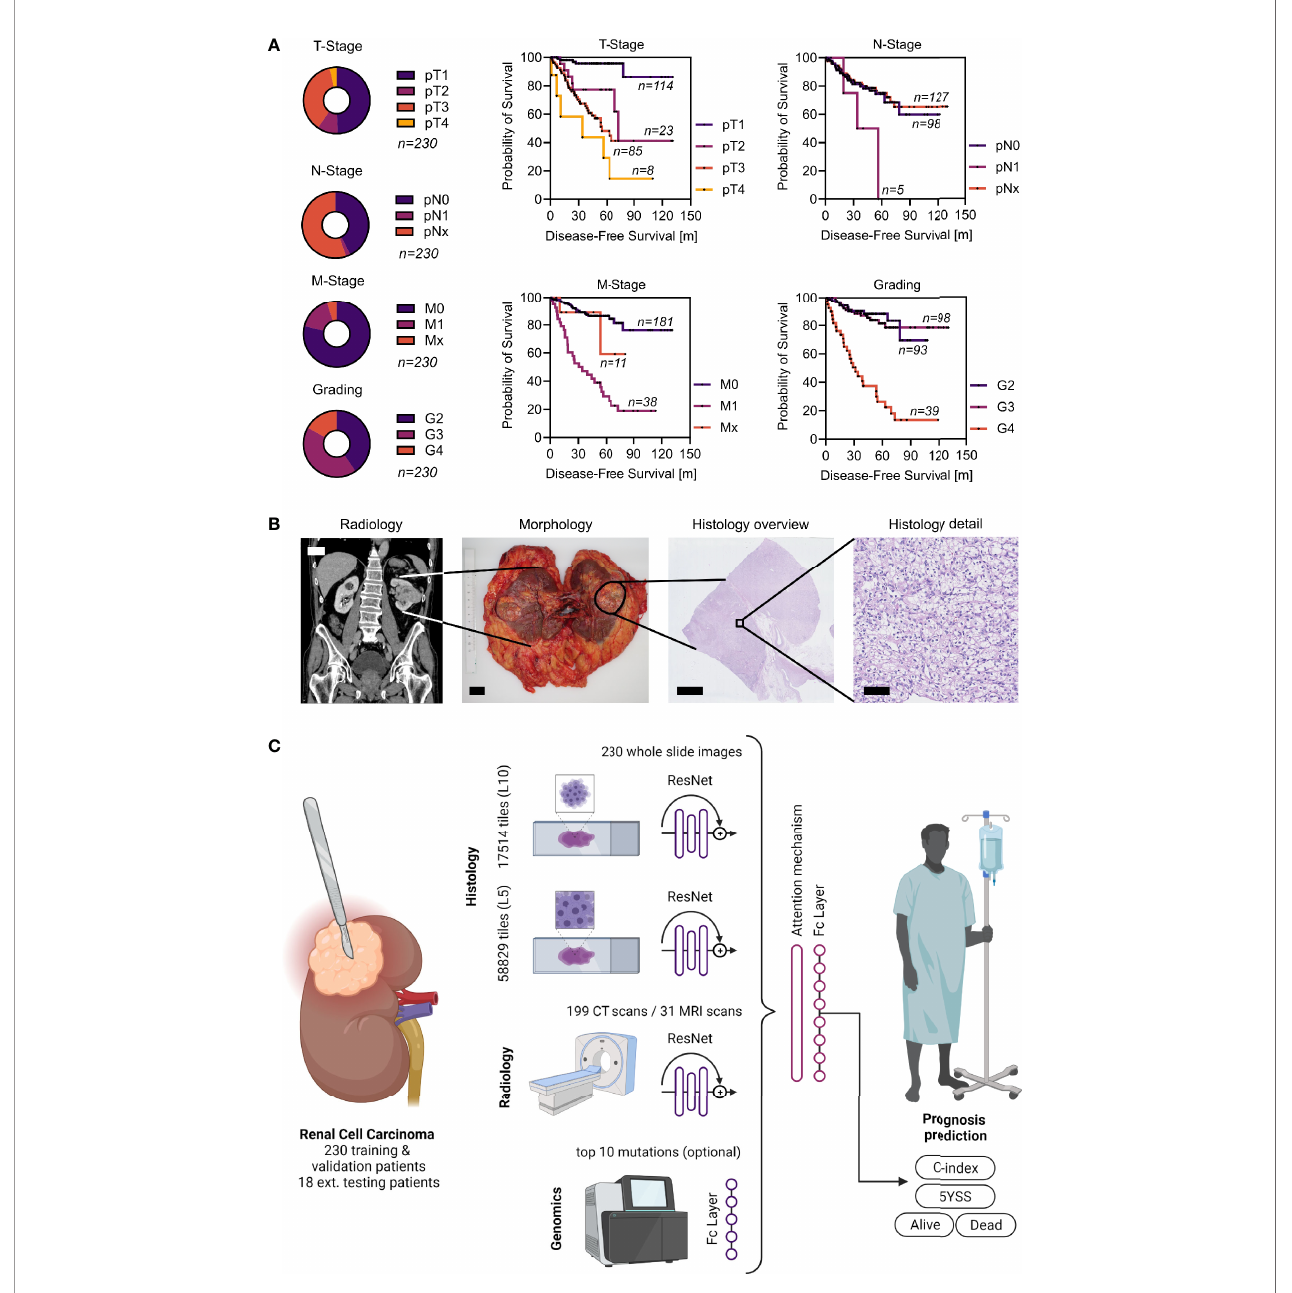
FIGURE 1 | Patient cohort, clinical example, and overview of the MMDLM. (A) Characteristics of the TCGA cohort. (B) Clinical example of a typical ccRCC case. CT (scalebar 5 cm), macroscopic (scalebar 2 cm), as well as histologic tumor appearance (scalebars 5 mm and 100 µm) are displayed. (C) Schematic overview of the model. Created with